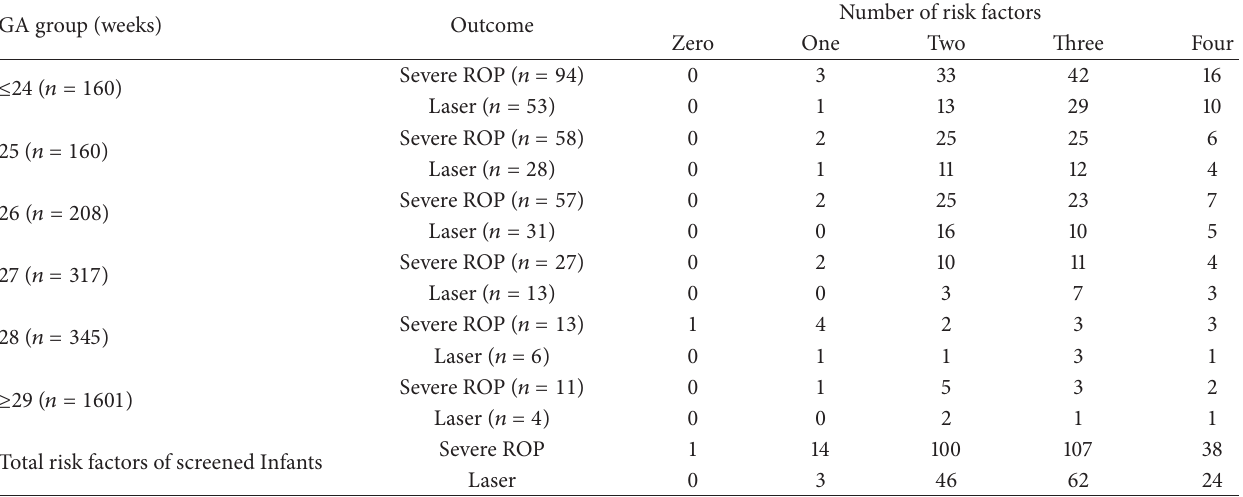
Table 3: Gestational age related frequency of risk factors for severe retinopathy of prematurity (ROP) or laser treatment.